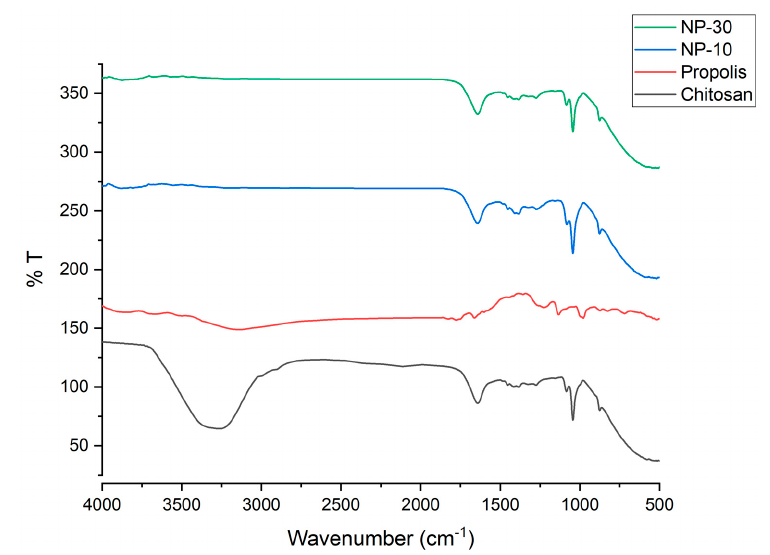
Figure 7. Nano-propolis-10 (NP-10; 840 mg/350 mL), nano-propolis-30 (NP-30; 1260 mg/180 mL), propolis and chitosan solutions (permanent phase) for FTIR data.